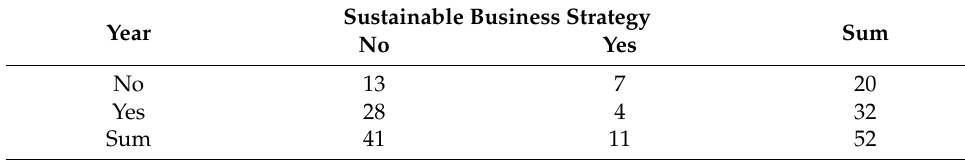
Table 9. Cross-way table for variables: Year and Sustainable Business Strategy